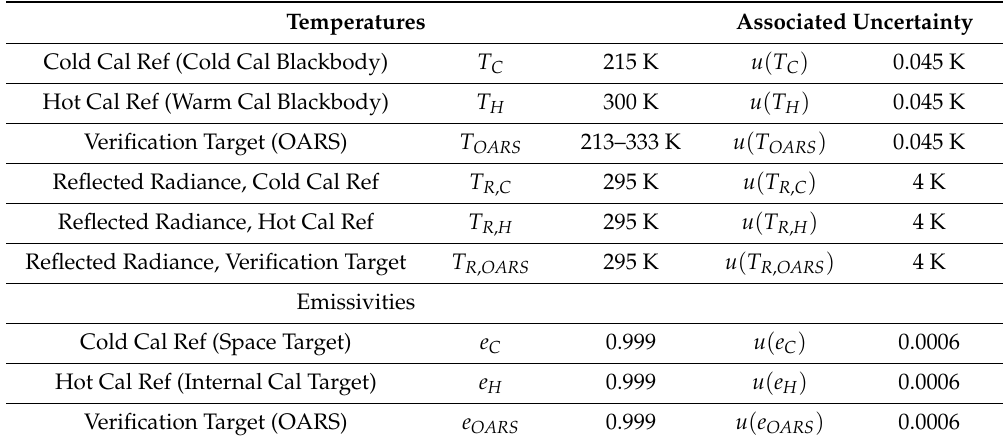
Table 5. Uncertainty estimates used in the radiometric uncertainty analysis for vacuum configuration. All specified uncertainties correspond to a k = 3 coverage factor.